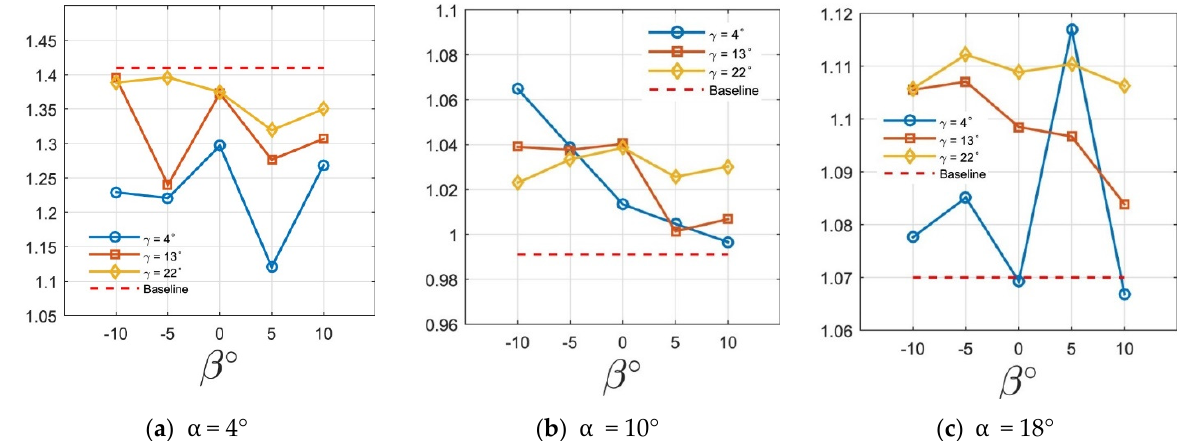
Figure 7. Interaction plots between the lift coefficient and the alula parameters at ( a ) α = 4°, ( b ) α = 10°, and ( c ) α = 18° at Re = 10 5 [19].